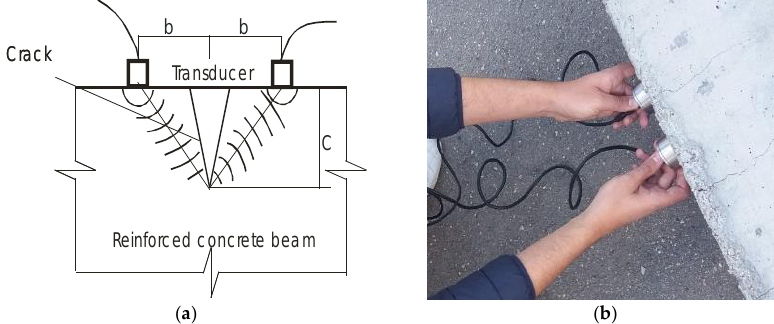
Figure 6. ( a ) Location of the transmitter and the receiver relative to the crack and distribution of the ultrasonic signal for normal cracks, ( b ) measurement (personal archive).